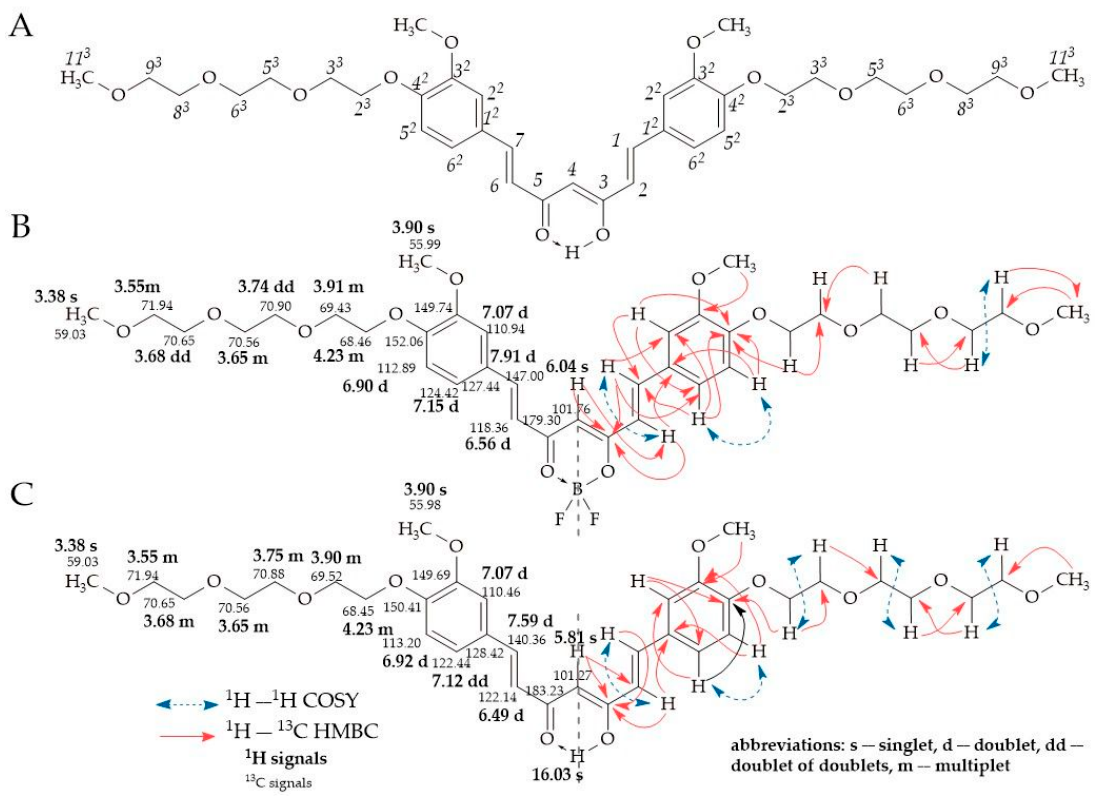
Figure 3. 1 H and 13 C NMR data for compound 5 and its BF 2 complex 4 in CDCl 3 . ( A ) Numbering of atoms within curcumin system; ( B ) Annotated 1 H and 13 C NMR signals for 4 ; and ( C ) Annotated 1 H and 13 C NMR signals for compound 5 . Chemical shift values: 1 H NMR (bold text) and 13 C NMR (normal text) are expressed in ppm. Key 1 H– 13 C HMBC and 1 H– 1 H COSY correlations are marked with red full-line arrows and blue dashed double arrows, respectively.